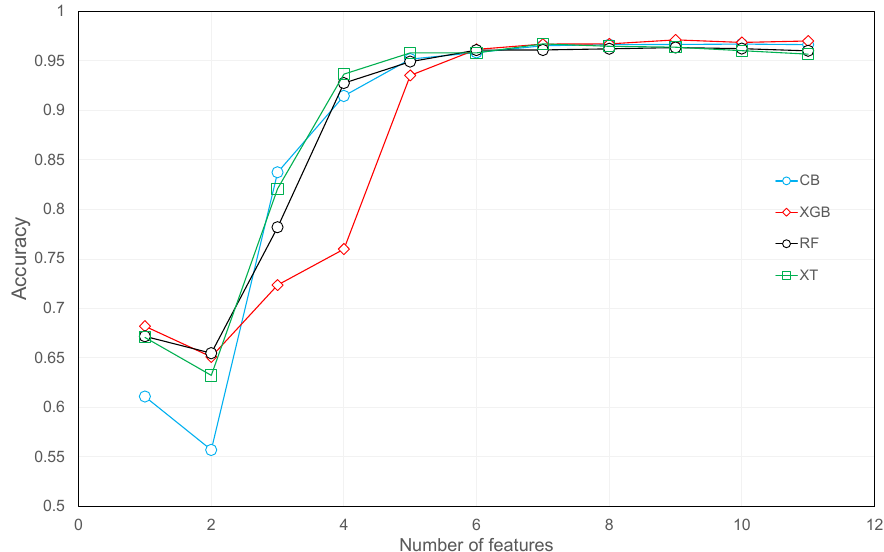
Figure 8. Accuracy during recursive feature elimination test.